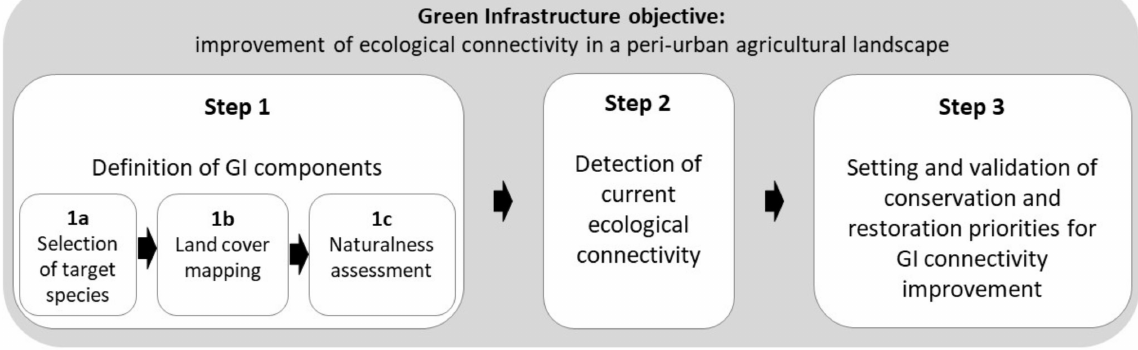
Figure 2. Multi-step procedure aimed at setting conservation and restoration priorities for GI connectivity improvement in the study